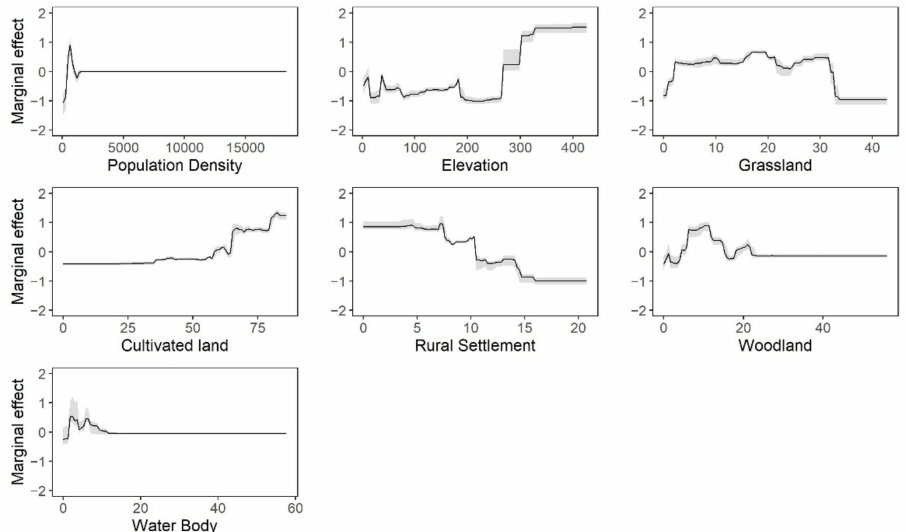
Figure 4. Marginal effect curves of each predictor. The black lines represent the mean effect, and the gray shaded areas represent the range of effect from all BRT models.